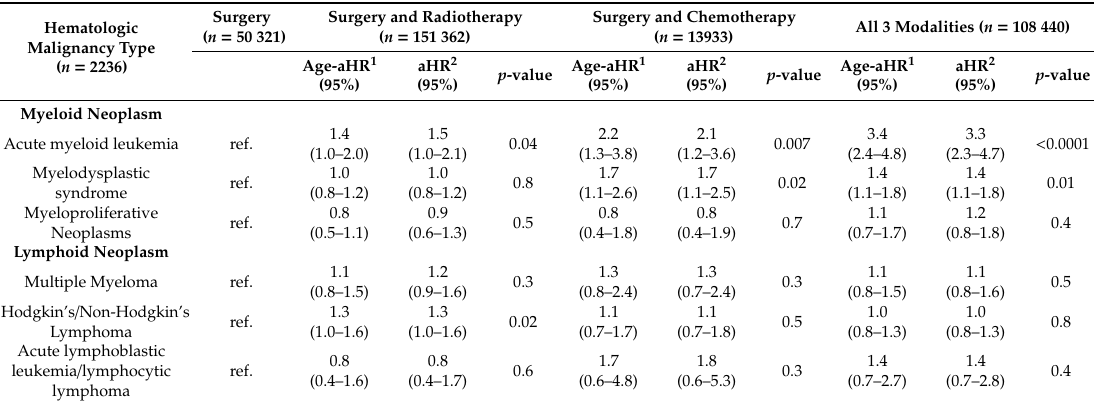
Table 3. Risk of hematologic malignancies (HRs) by exposure